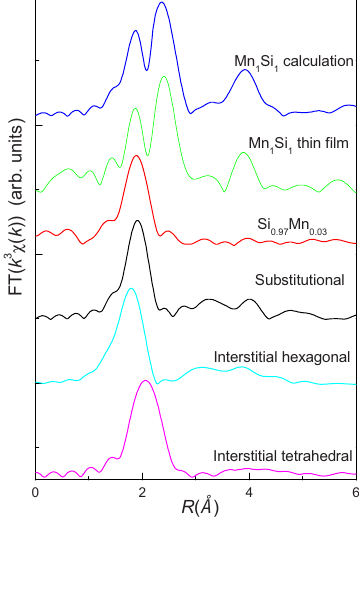
Figure 14 . Comparison of the radial structural functions from theoretical calculations and the experimental radial structural functions of the Si found that the experimental spectrum with a strong peak (1.90 ˚ A ) in the Si is exactly reproduced by the calculated spectrum for substitutional MnSi. (Reprinted with permission from Ref. [73]. Copyright 2009, American Institute of